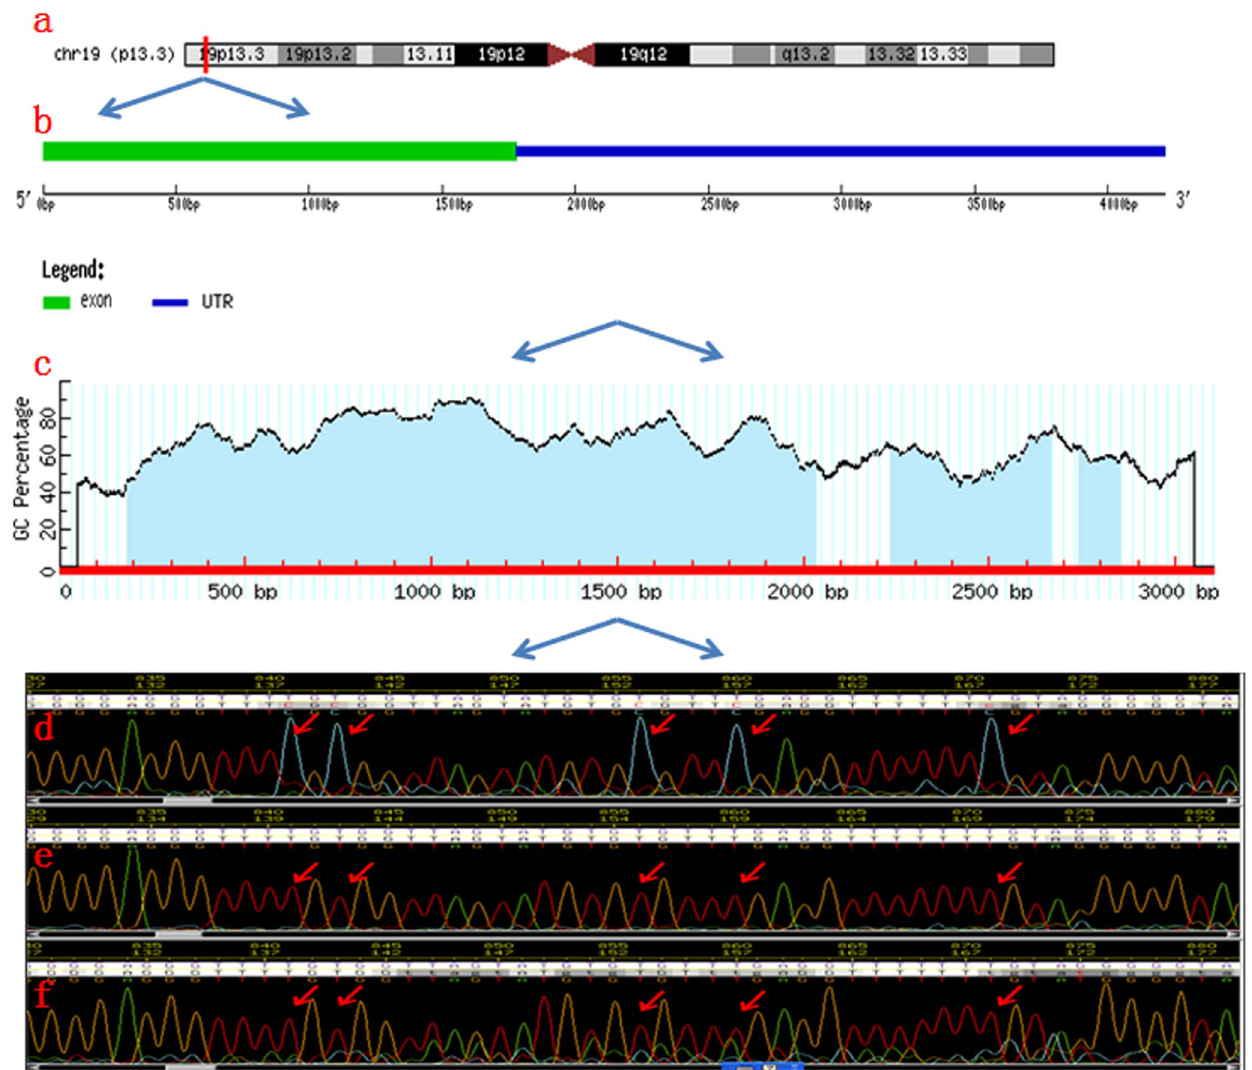
Figure 4. Genomic architecture of the human TCF3 gene. Location of the TCF3 gene within human chromosome 19 (ch19p13.3). (a) Exon structure of the human TCF3 gene. (b) Structure of the 5 9 end of the TCF3 gene. Graph of percent guanine (G) and cytosine (C) nucleotides across this region, location of the CpG dinucleotides within this region, and boundaries of the CpG island (shaded region). (c) Representative examples of the chromatograms of CpG sites obtained from bisulphite sequencing of the TCF3 fragment in CRC without recurrence (d) and with recurrence (e,